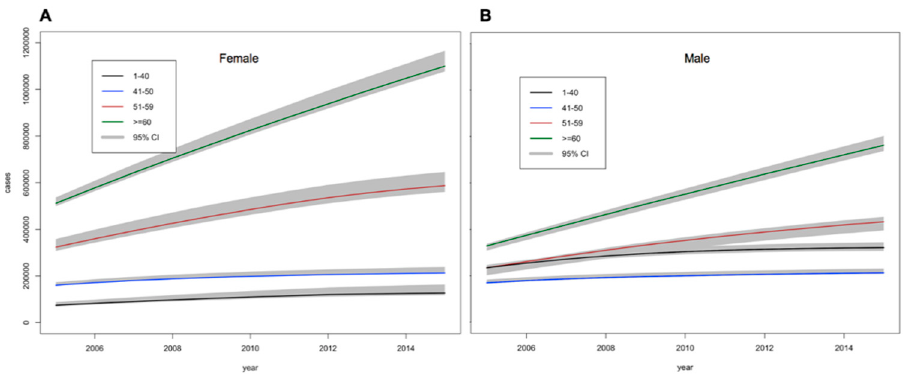
Figure 2. Estimations of the number (95% credible intervals) of ( A ) females and ( B ) males with diabetes between 2005 and 2015 by age.